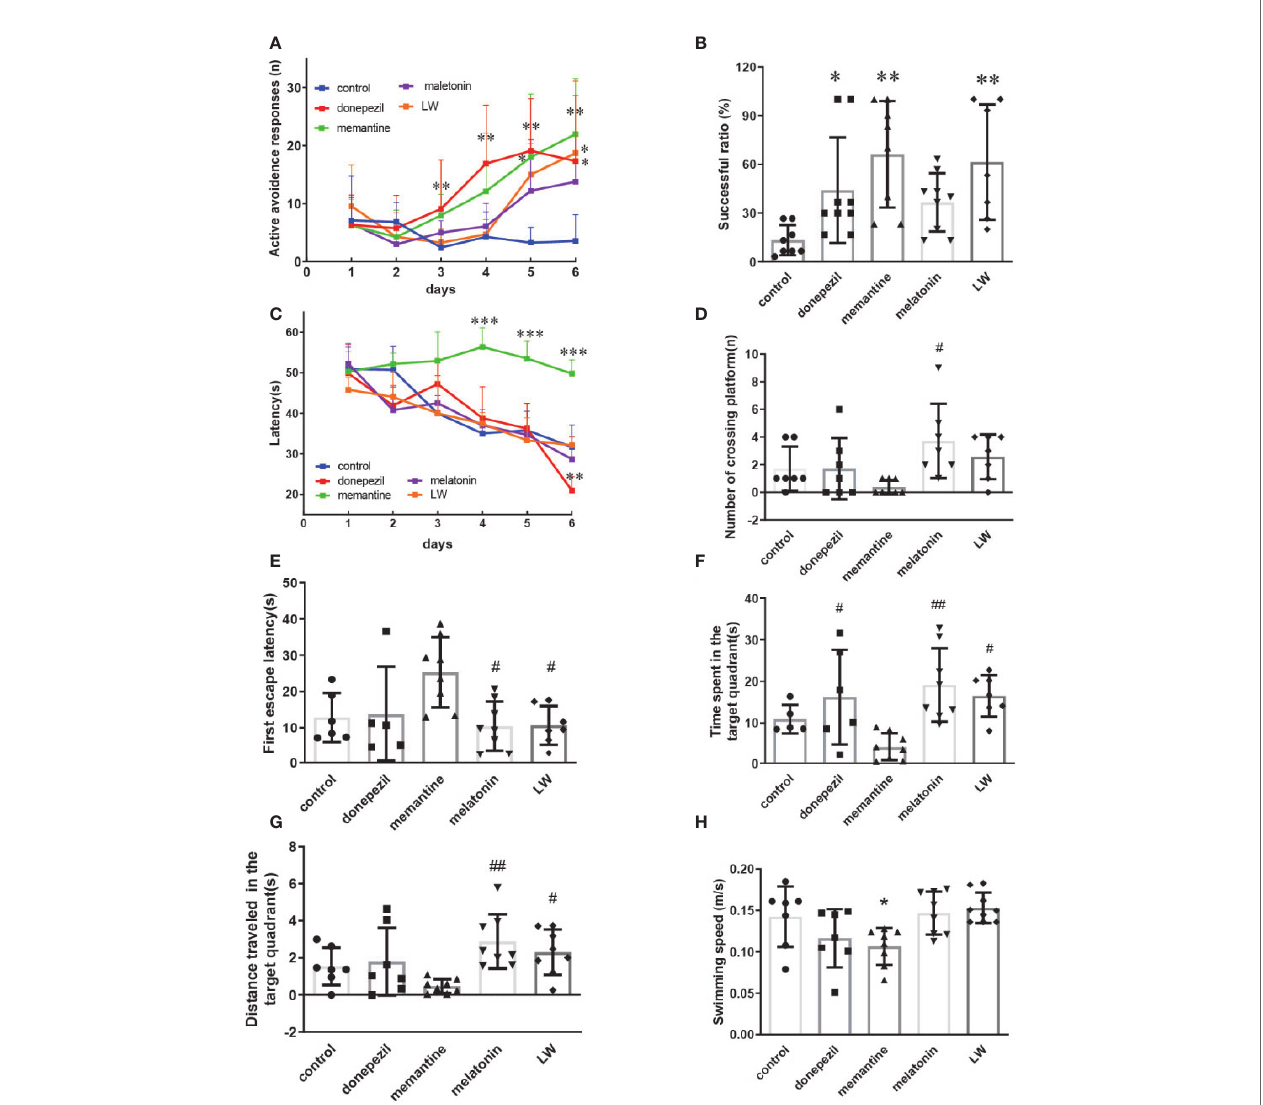
FIGURE 3 | The effects of donepezil, memantine, melatonin, and LW on the active avoidance responses, spatial learning and memory in old SAMR1 mice. The successful avoidance times in training phase (A) and testing phase (B) in shuttle box test. n=9~10(male: n=4, female: n=5~6).The escape latency of mice in learning task (C) and probe trial (E) , number of crossing the platform (D) , the time spent in the target quadrant (F) , distance traveled in the target quadrant (G), and swimming speed (H) in the Morris water maze test; * P < 0.05, ** P < 0.01, *** P < 0.001, vs control group. Kruskal-Wallis test. # P < 0.05, ## P < 0.01, vs memantine group, Kruskal-Wallis test. mean ± S.D., n = 7~9 (male: n = 2~4, female: